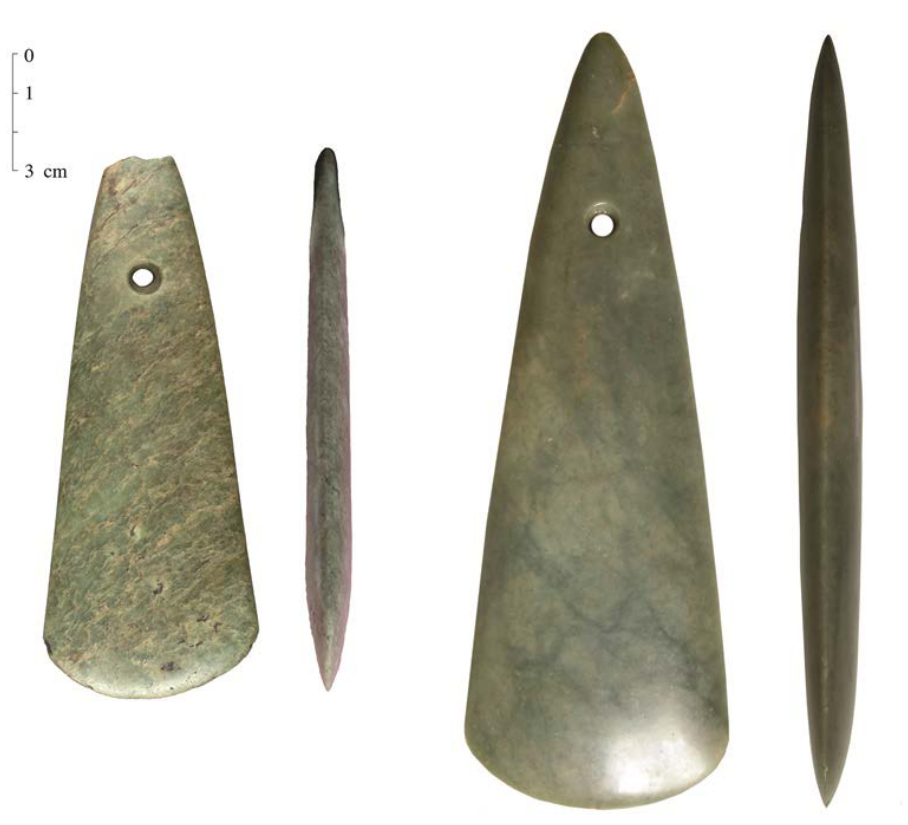
Figure 3. Comparison between the Vilapedre axe (left) and a perforated Tumiac type from the "tumulus de Tumiac" (Brittany, France) (right). Photos P. Pétrequin and R.